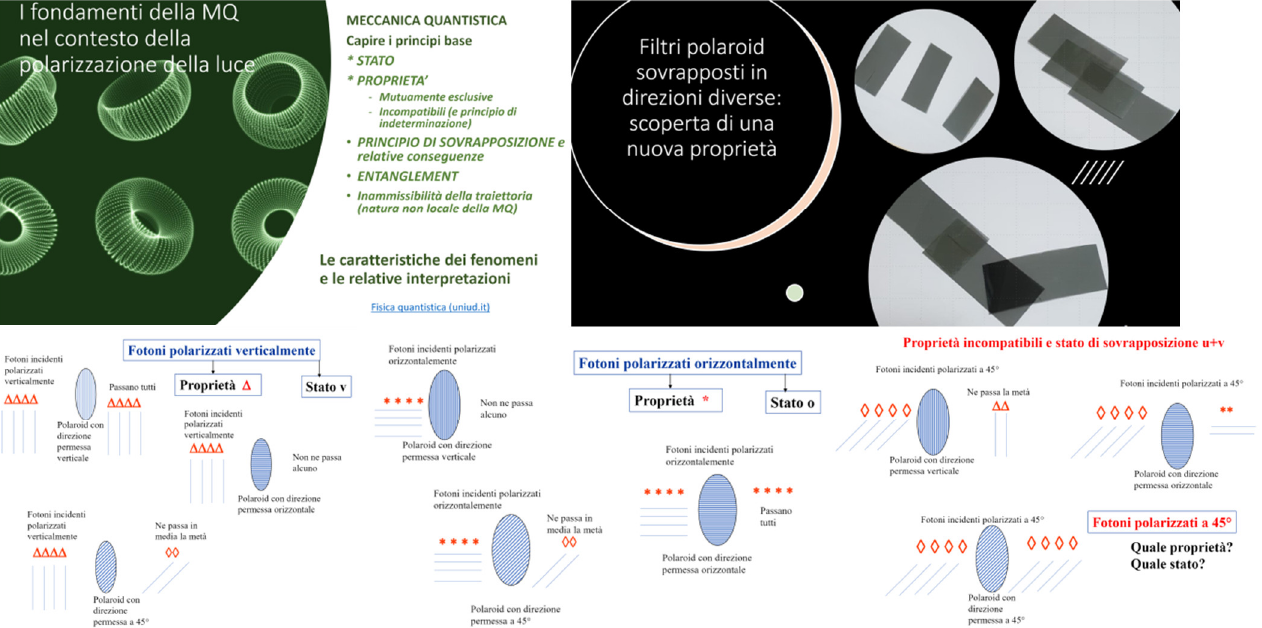
Figure A3. Examples from the specific path “Fundamentals: Polarization”. Screenshots of the slides used during the lectures. Top left : summary of the lectures. Top right : examples of polaroid superposition. Bottom : schematics of the behavior of polarized photons passing through polaroid filters.